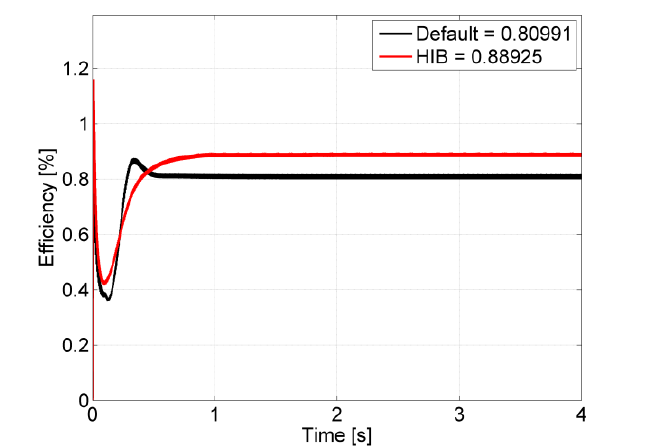
Fig. 16. SRG efficiency after hybrid GA